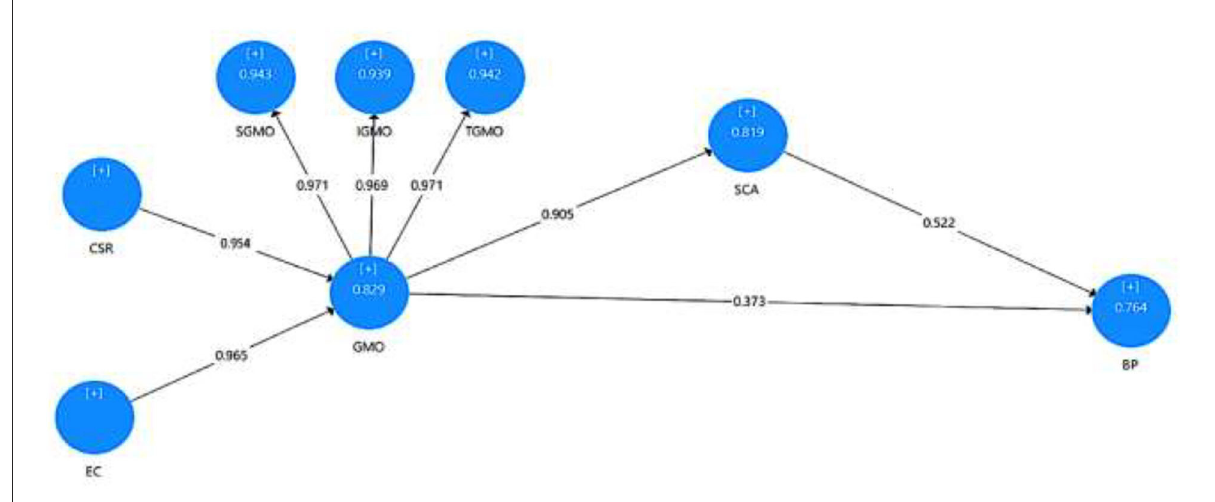
FIGURE2 Hypothesized